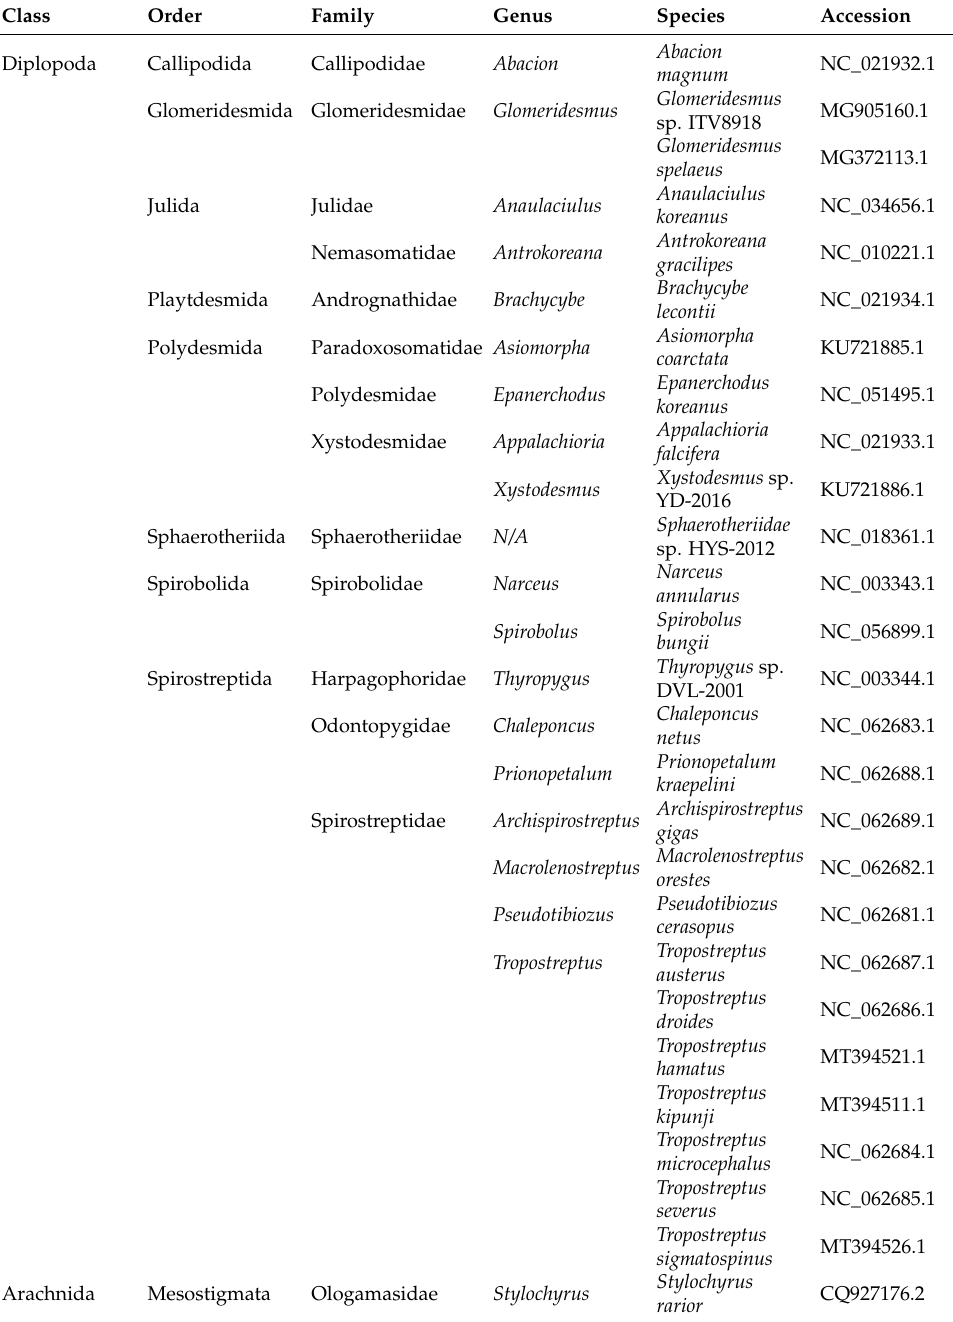
Table 1. List of complete mitogenomes used in this